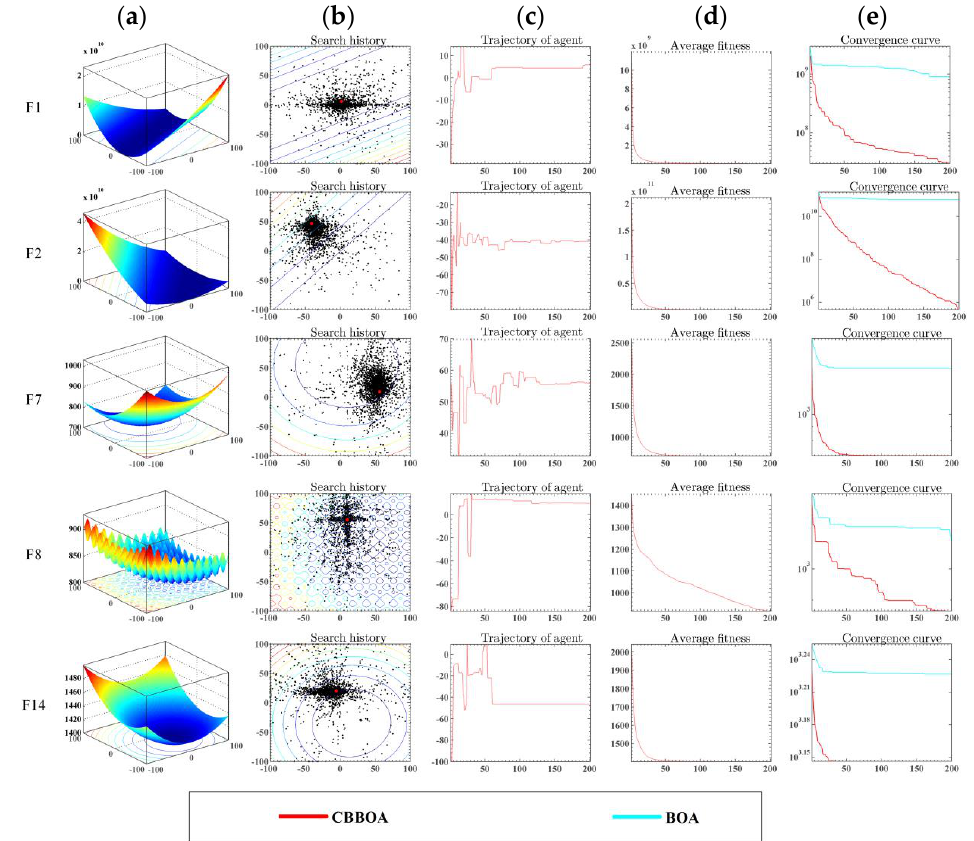
Figure 5. ( a ) Three-dimensional location distribution of CBBOA, ( b ) two -dimensional location distribution of CBBOA, ( c ) Trajectory of CBBOA in the first dimension, ( d ) Average fitness of CBBOA, ( e ) Convergence curves of CBBOA and BOA.